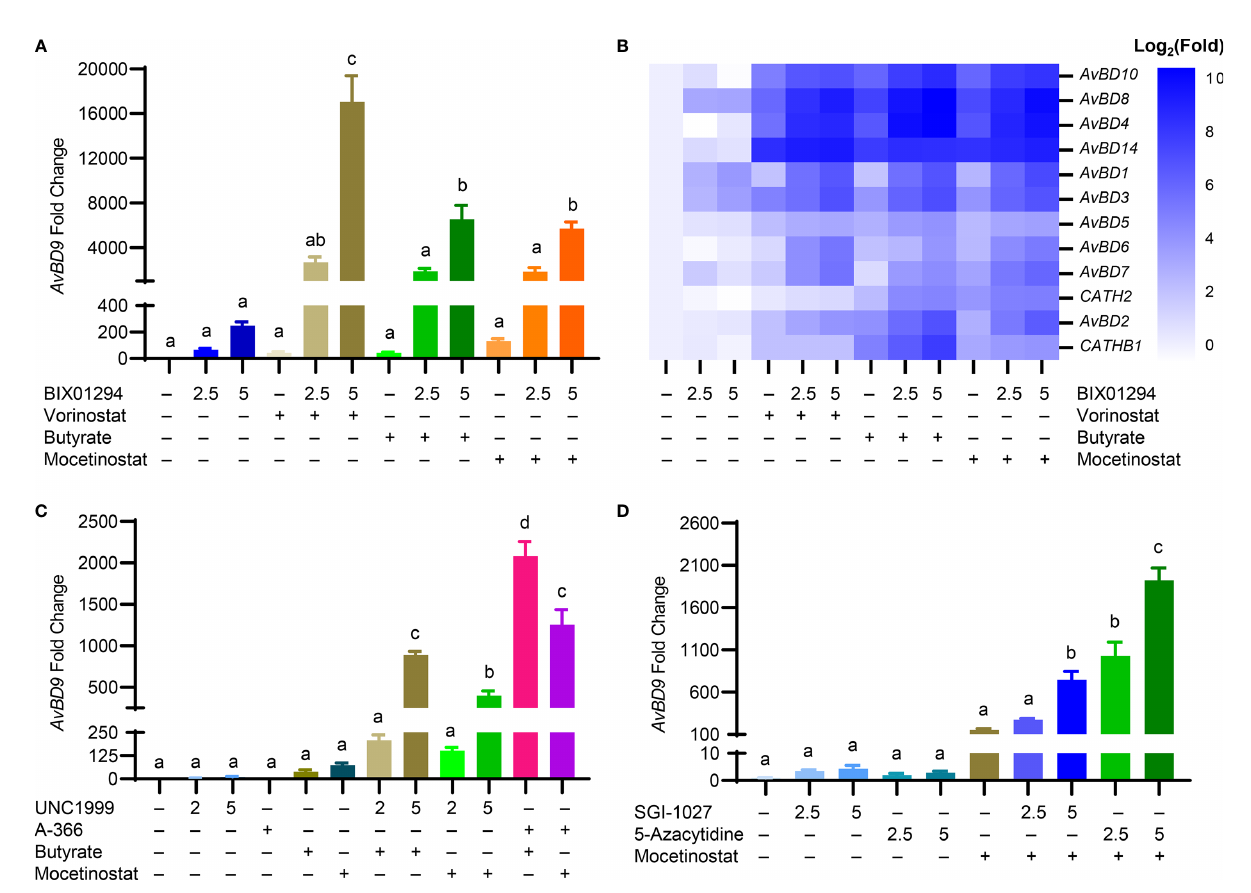
FIGURE 7 | Synergistic induction of chicken HDP mRNA expression in HTC cells between HMTi and HDACi or between DNMTi and HDACi. Chicken HTC cells were stimulated in duplicate with an HMTi (2.5 or 5 m M BIX01294) in the presence or absence of one of three HDACi (5 m M SAHA, 2 mM butyrate, or 2.5 m M mocetinostat) for 24 h, followed by RT-qPCR analysis of the expressions of AvBD9 (A) and other chicken HDP genes (B) . (C) Chicken HTC cells were stimulated in duplicate with an HMTi (2 or 5 m M UNC1999 or 5 m M A-366) individually or in combination with an HDACi (2 mM butyrate or 2.5 m M mocetinostat) for 24 h, followed by RT-qPCR analysis of the expressions of AvBD9 gene. (D) Chicken HTC cells were stimulated in duplicate with a DNMTi (2.5 or 5 m M SGI-1027 or 5-azacytidine) individually or in combination with a HDACi (2 mM butyrate or 2.5 m M mocetinostat) for 24 h, followed by RT-qPCR analysis of AvBD9 expression. Results are shown as means ± SEM of three independent experiments. The bars not sharing a common superscript are considered signi fi cantly different ( P < 0.05) based on one-way analysis of variance and post hoc Tukey ’ s